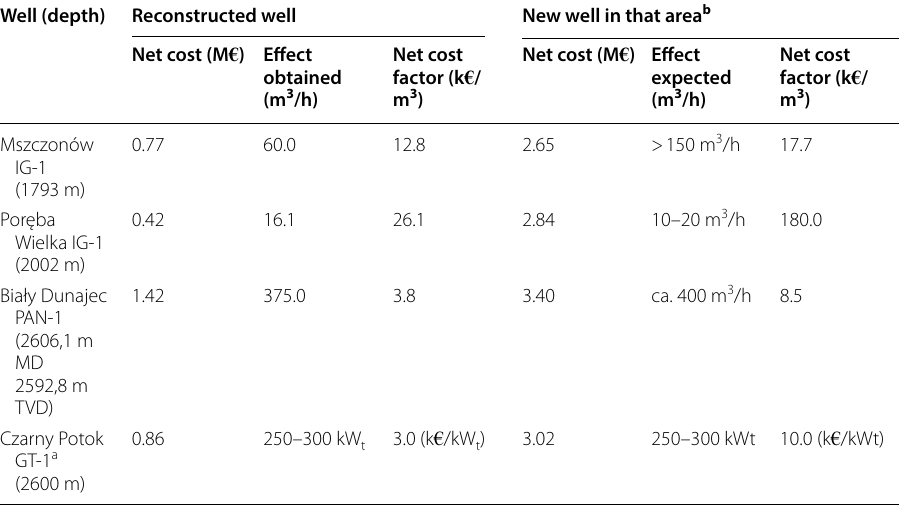
a Negative well (project for coaxial hole heat exchanger was designed) (reconstruction project not implemented) b Estimated values